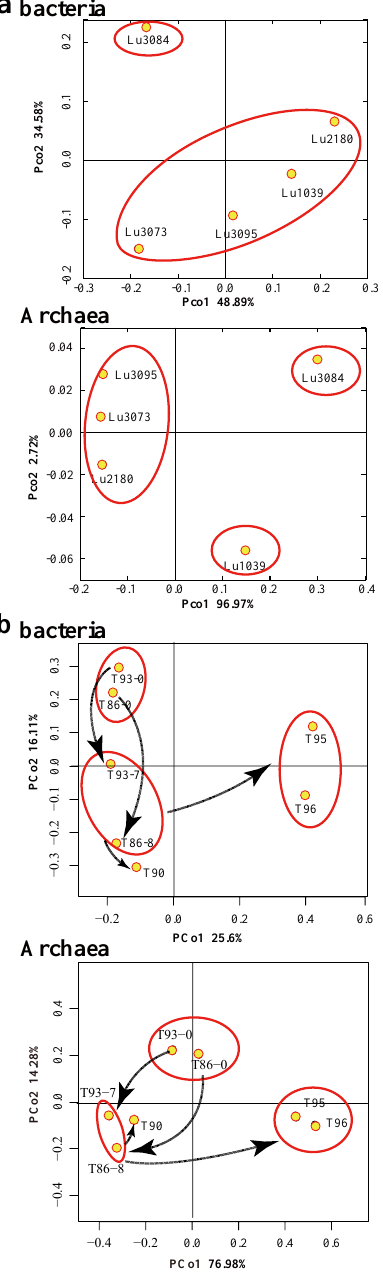
Figure 6. Principal coordinate analysis of microbial communities used to investigate the microbial distribution in injected water and reservoir strata. (a) Sandstone and (b) conglomerate reservoirs. Bacteria: bacterial community distribution; Archaea: archaeal com- munity distribution. Sample points that are close together are more similar in community composition than those that are far apart. The arrows in panel (b) indicate the community succession during the process of the injected water flowing into the injection wells and the neighbouring production